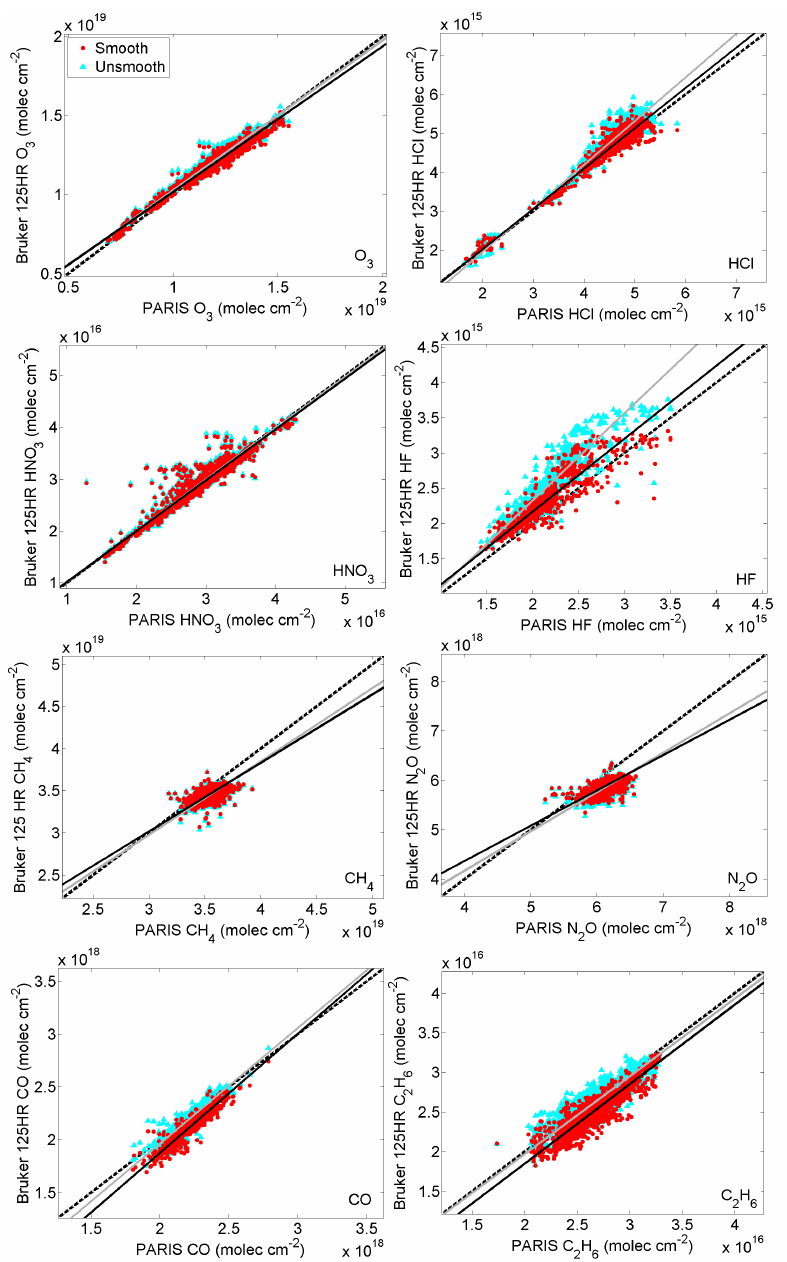
Figure 2. PARIS-IR versus Bruker 125HR total columns for each of the trace gases used in this study, showing the correlation before (cyan triangles) and after smoothing (red dots). The line of best fit is shown as a thin grey line for the unsmoothed total columns and as a thick black line for the smoothed total columns. The dashed black line represents the one-to-one line as a reference. Slopes and correlation coefficients are given in Table